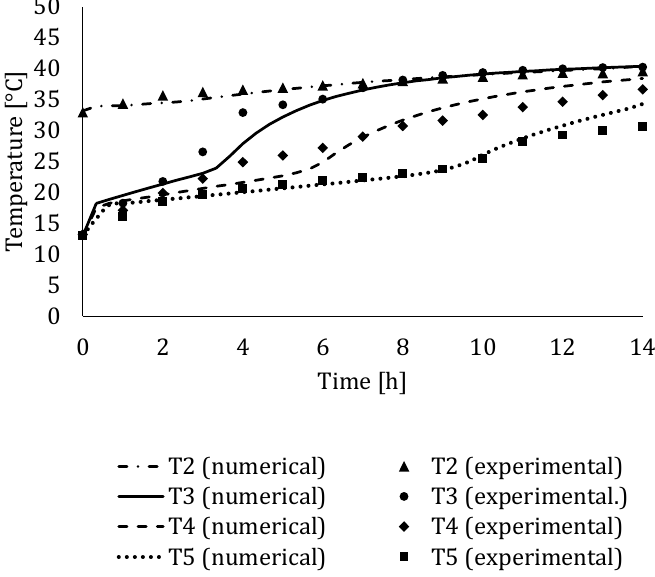
Figure 9. Comparison of transient temperature variations of the HTF and PCM during melting obtained numerically and experimentally at positions T2, T3, T4 and T5 for HTF flow rate 620 l/h and HTF inlet temperature 42 °C.